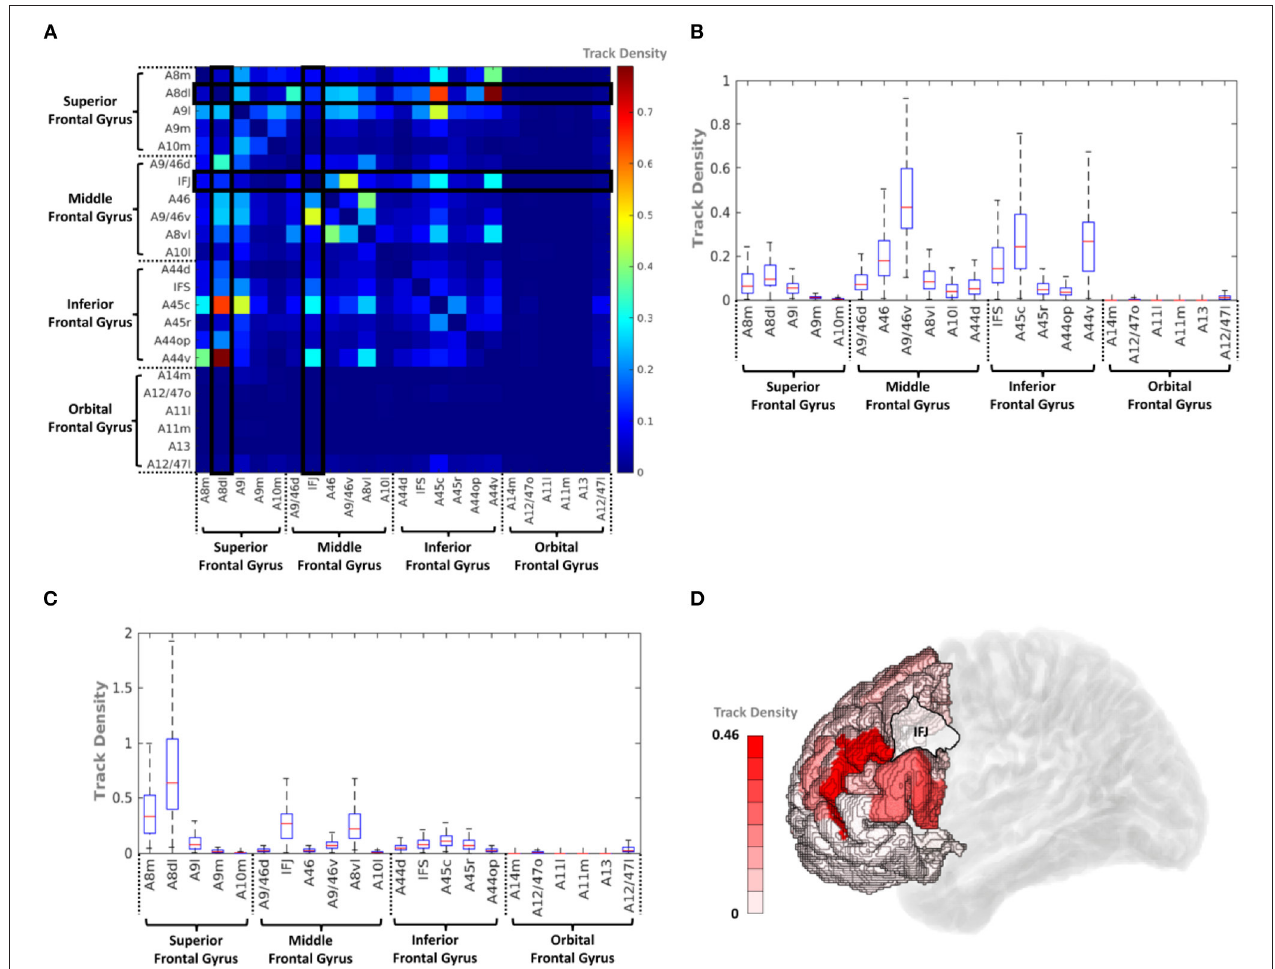
FIGURE 8 | (A) Average track density matrix of the acquired short fiber tracts from the PFC. (B) Box-and-whisker plot showing the PFC–IFJ connectivity specifically for the regions indicated in (A) . (C) Box-and-whisker plot showing the PFC–A44v connectivity specifically for the regions indicated in (A) . (D) Three-dimensional visualization of track density within PFC–IFJ focused short fiber connectivity. A8dl, dorsolateral area 8; A8m, medial area 8; A9l, lateral area 9; A9m, medial area 9; A9/46d, dorsal area 9/46; A10m, medial area 10; A8vl, ventrolateral area 8; A10l, lateral area 10; A11l, lateral area 11; A11m, medial area 11; A12/47l, lateral area 12/47; A12/47o, opercular area 12/47; A13, area 13; A14m, medial area 14; A44d, dorsal area 44; A45c, caudal area 45; A45r, rostral area 45; A44op, opercular area 44; A44v, ventral area 44; A46, area 46; IFJ, inferior frontal junction; IFS, inferior frontal